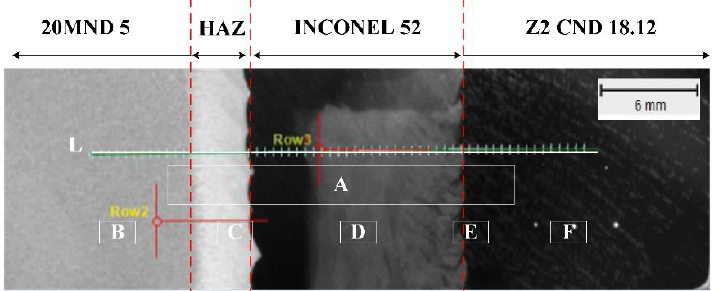
Figure 4. Locations for observing micro-structures (from A to F ) and measuring micro-hardness (along L line) along the DMW joint.